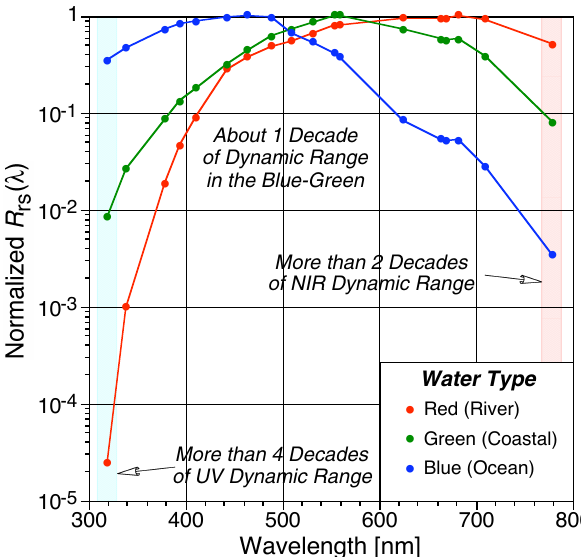
Fig. 2. Averaged Malina R rs (λ) = L W (λ)/E d ( 0 + ,λ) spectra, nor- malized by the peak value of the spectrum. The spectra are sepa- rated into three groups based on the peak wavelength domain (blue, green, and red) and classified as river, coastal, or ocean based on the preponderance of the sampling